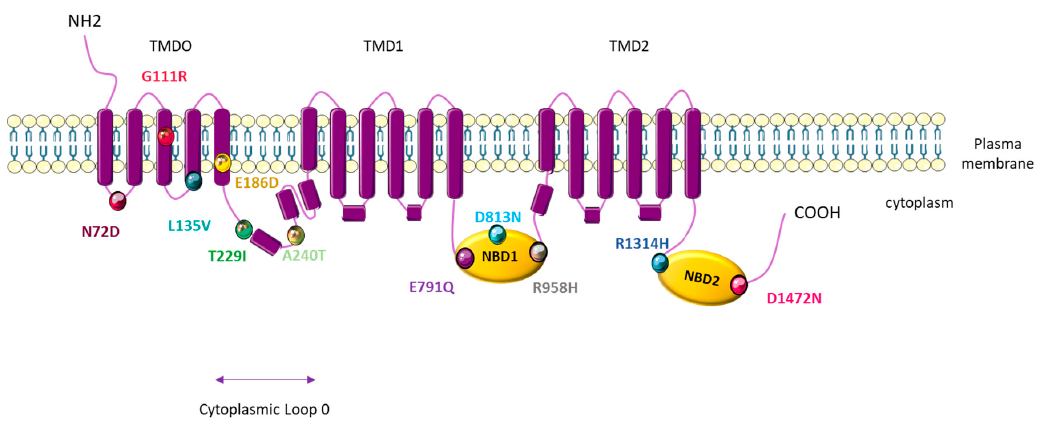
Figure 5. Topological analysis of the human ATP-binding cassette subfamily C member 8 ( ABCC8)/sulfonylurea receptor 1 (SUR1) channel. Positions indicate the mutations identified by Bohnen M et al.